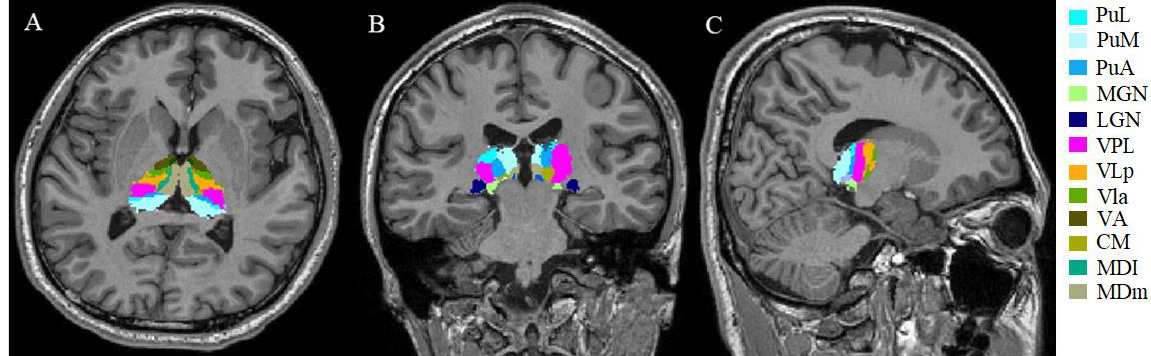
Figure 1. Example of segmentation of thalamic nuclei. Segmentation and labeling of thalamic nuclei in axial plane ( A ), coronal plane ( B ), and sagittal plane ( C ) generated by FreeSurfer (not all segmentations are shown). The segmentations are overlaid on the 3D T1-weighted scan. PuL: pulvinar lateral, PuM: pulvinar medial, PuA: pulvinar anterior, MGN: medial geniculate, LGN: lateral geniculate, VPL: ventral posterolateral, VLp ventral lateral posterior, VLa: ventral lateral anterior, VA: ventral anterior, CM: centromedian, MDl: mediodorsal lateral parvocellular, MDm: mediodorsal medial magnocellular